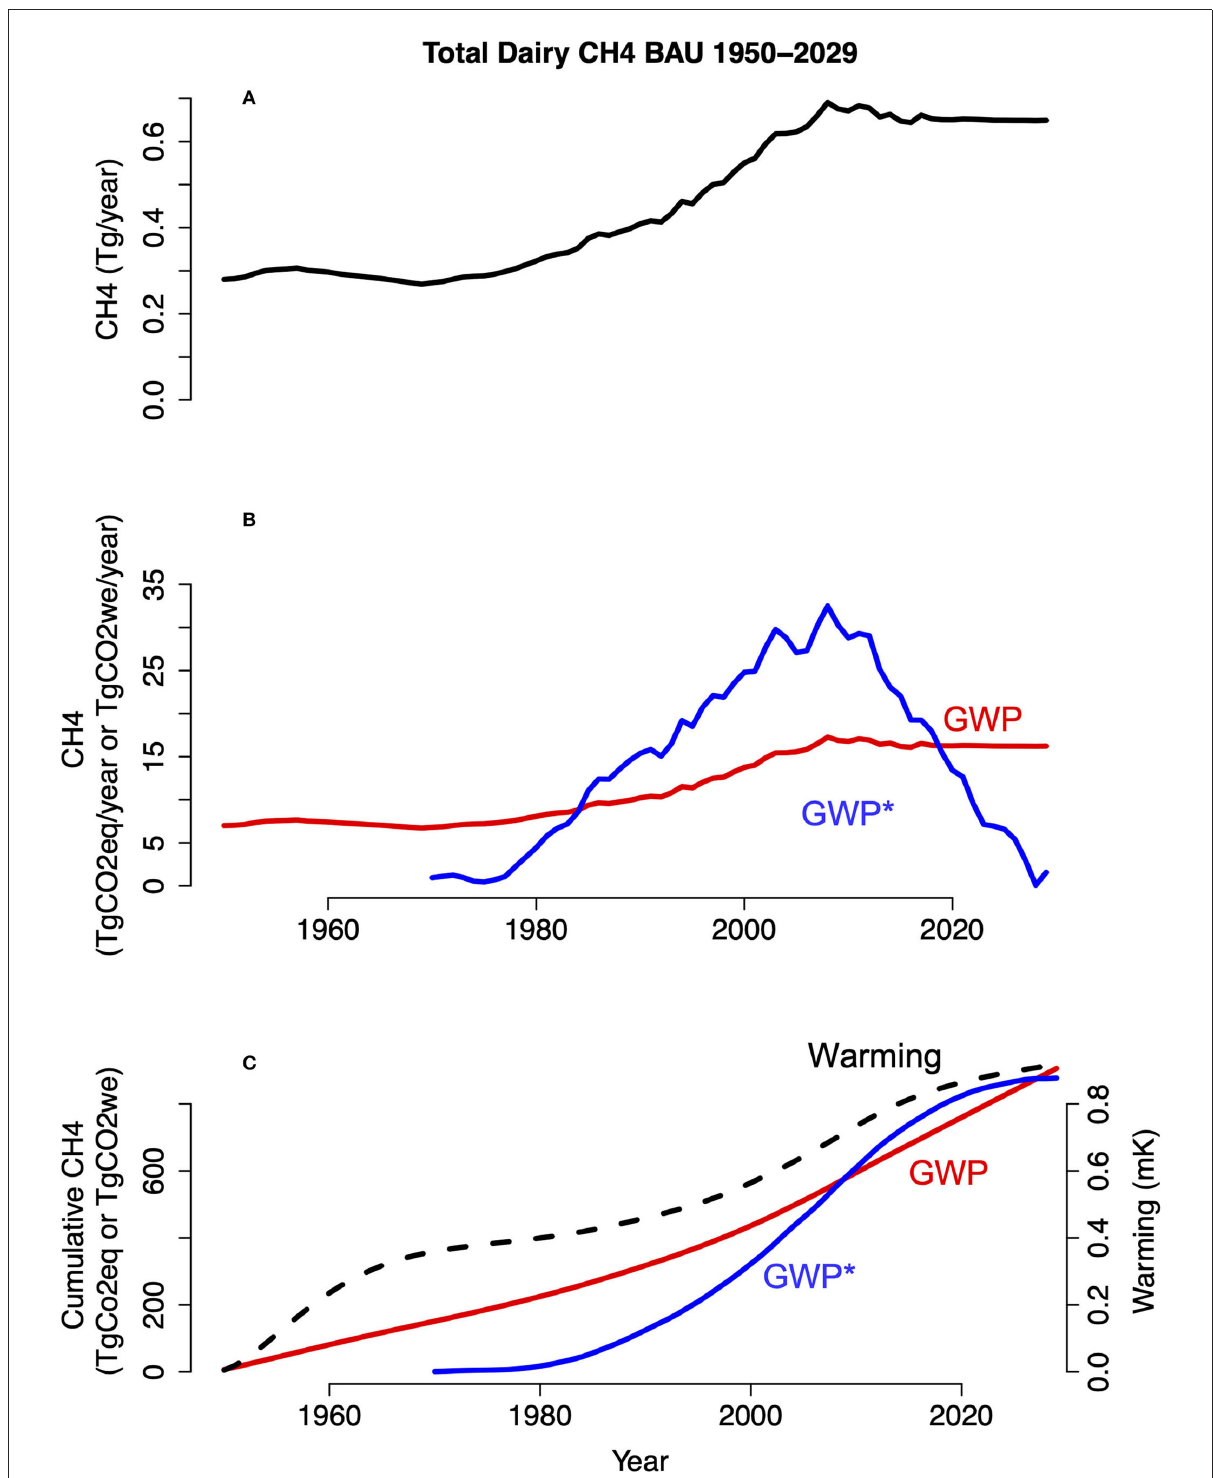
FIGURE3 California future BAU total (enteric fermentation plus manure management) CH 4 emissions, comparison of these emissions converted to CO 2 eq and CO 2 we using GWP and GWP*, respectively, and cumulative CO 2 eq and CO 2 we with emissions-forced warming. The x -axis represents years and the y -axis represents annual CH 4 emissions (A) , annual CO 2 eq or CO 2 we (B) , or cumulative CO 2 eq or CO 2 we (C) . CO 2 we are represented in (B, C) by the blue solid line (“GWP*”), CO 2 eq are represented by the red solid line (“GWP”), and temperature is given in (C) by the dashed black line (“Warming”). The temperature axis (C) is scaled by 0.001 mK/TgCO 2 , or 1 K/TtCO 2 , as in Figure